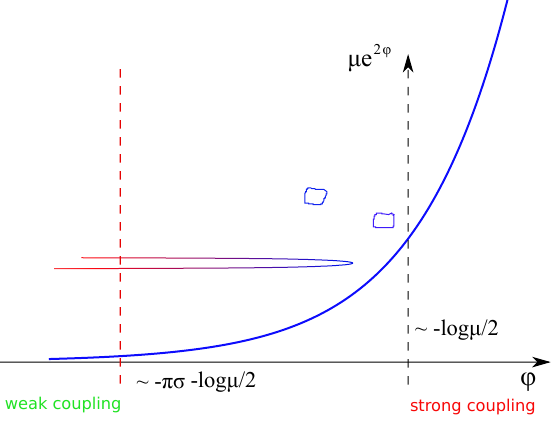
Figure 5 . The scattering of closed and open strings. Closed strings only see the bulk Liouville wall, while open strings have their endpoints pinned by the boundary